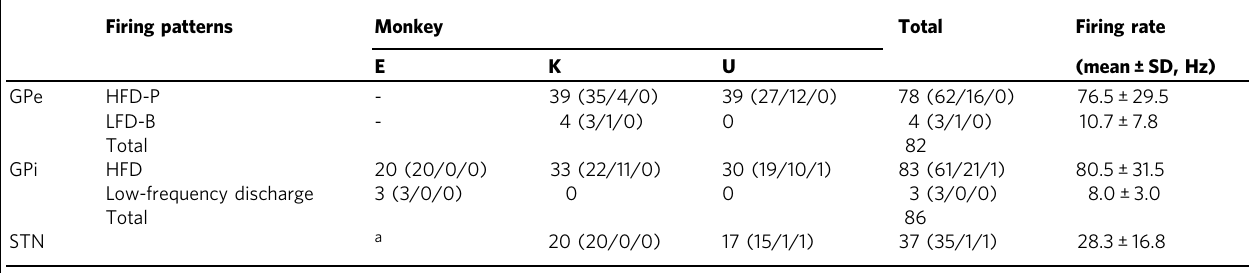
Table 1 Number of STN, GPe, and GPi neurons examined during task performance. Firing